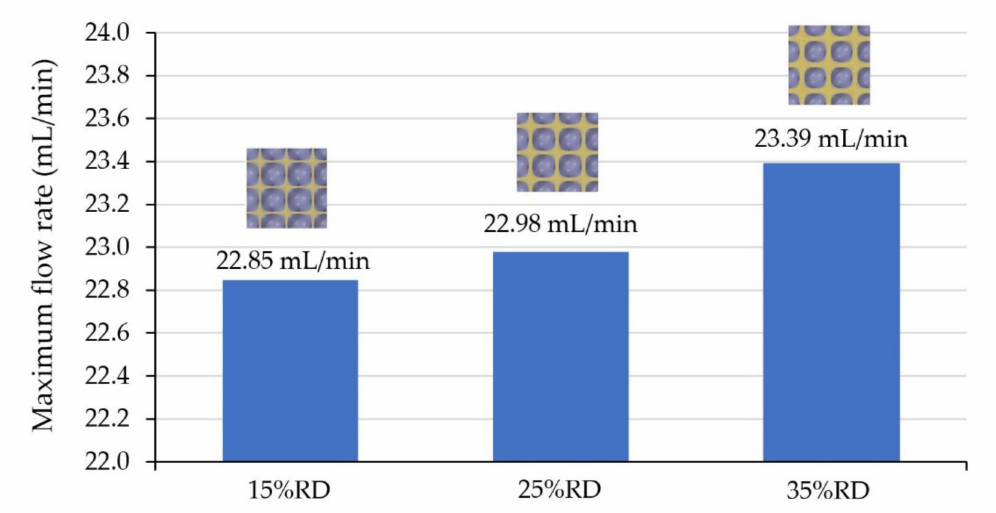
Figure 18. Maximum flow rate of Diamond with varying